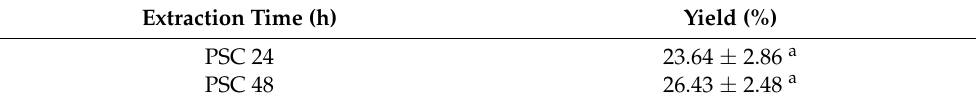
Table 1. The yield of extracted silver catfish skin collagen at different extraction times.